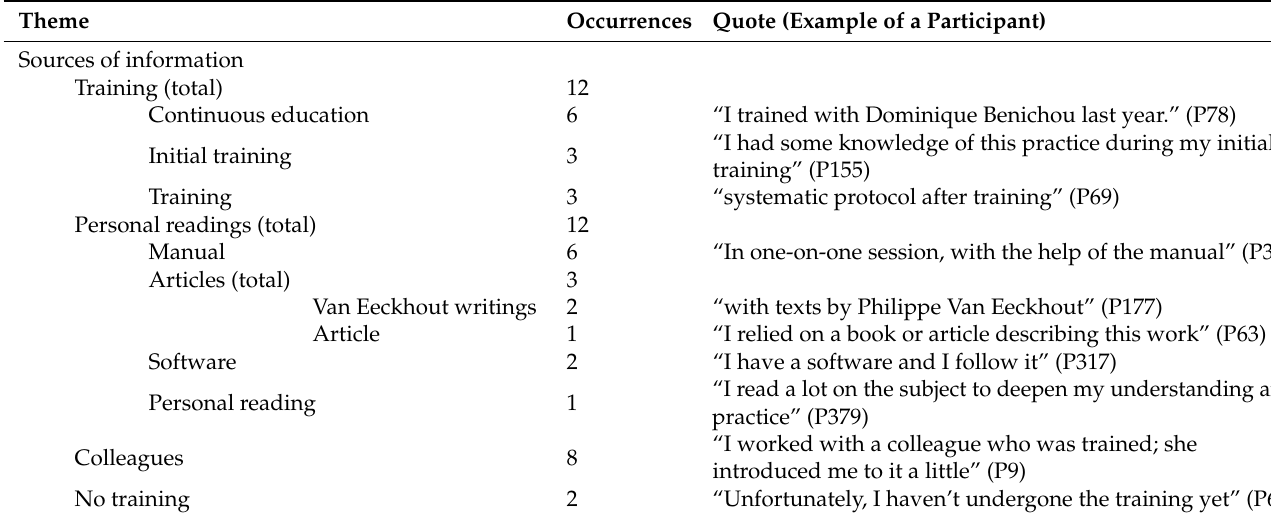
Table 2. Thematic analysis of open-ended answers to question 16: “Could you briefly describe